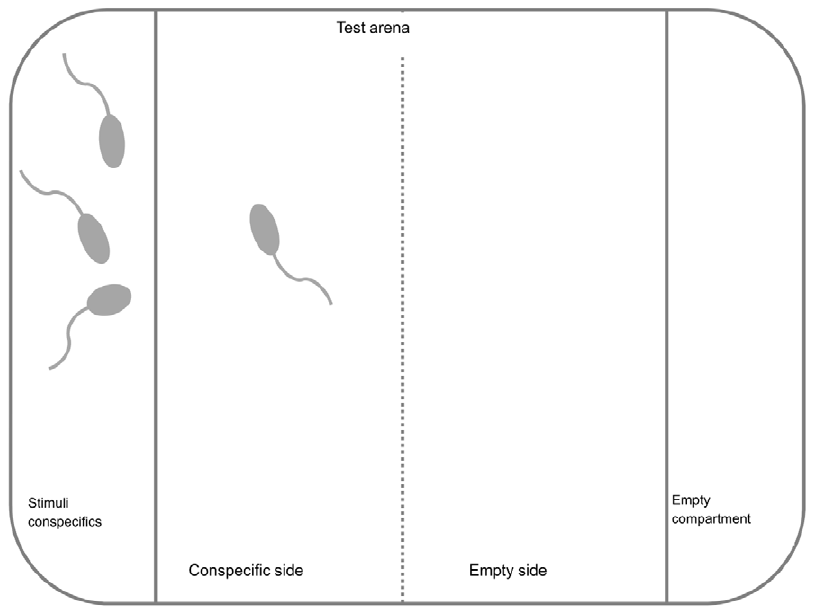
Figure 1. Test arena design. Arena with adjoining compartments on either side to hold conspecifics (test stimulus). A line on the base of the chamber (here dashed) divided the arena into